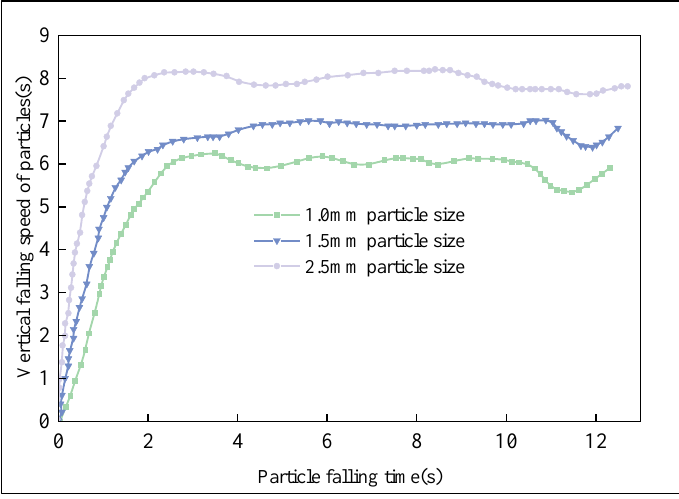
Figure 12. Vertical velocity variation of particles in the tower.